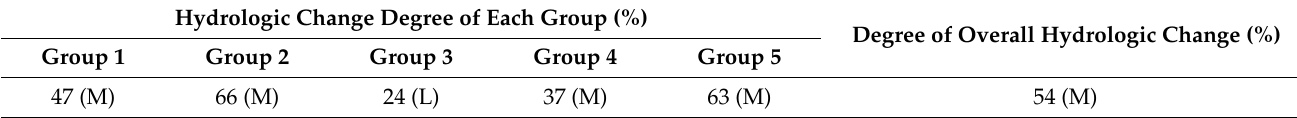
Table 4. Hydrological change degree of each group of IHA indicators.